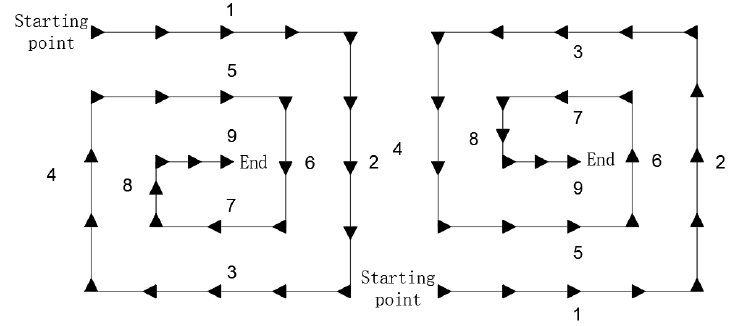
Figure 5. A “loop” cutting path track diagram.